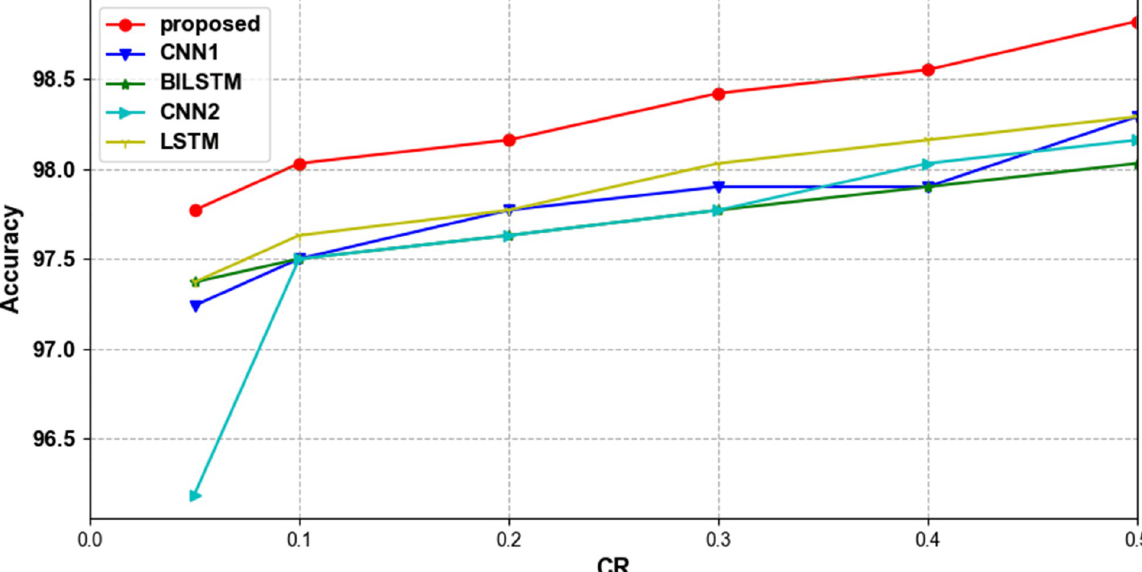
Fig 10. Trends in accuracy using different classification methods at different compression ratios in the MIT-BIH arrhythmia database.